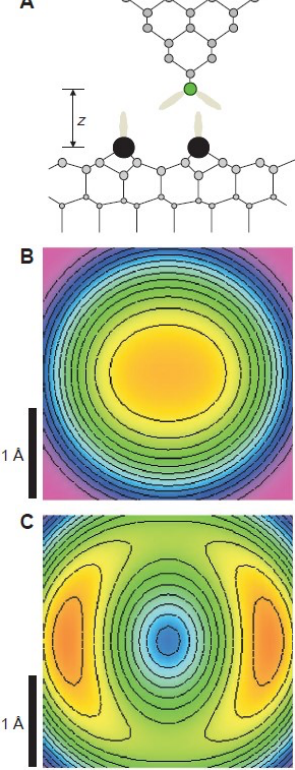
Figure 22. ( A ) Schematic drawing of the geometry used for the calculation, sketching the 3sp 3 hybrid orbitals of the tip atom (green sphere) and sample adatoms (black spheres). Simulated 2.8Å by 2.8Å constant height images of a single adatom ( B ) at z = 310pm and ( C ) z = 285pm. Adapted with permission by American Association for the Advancement of Science from Figure 4 in [17].